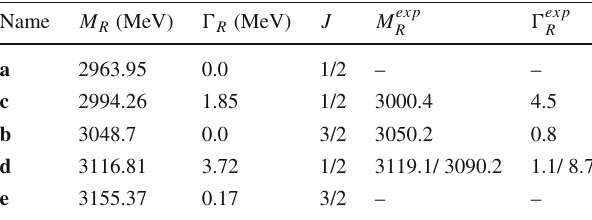
Table 4 (cid:2) c and (cid:2) ∗ c states calculated using the subtraction constants associated to a cutoff of (cid:3) = 1090 MeV. We identify experimentally two J = 1 / 2 and one J = 3 / 2 states